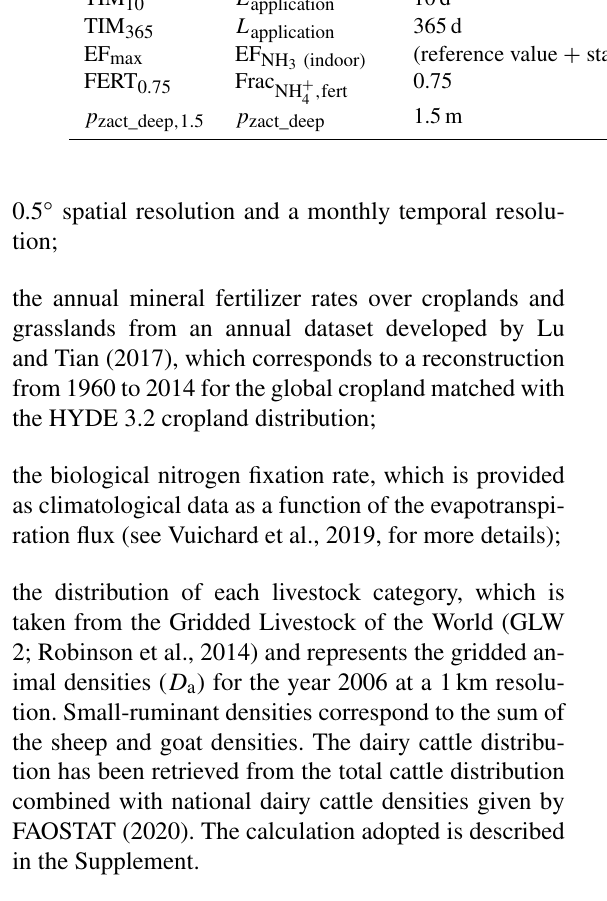
parameter is described in Sect. 2.1 for housing 3 ( indoor )